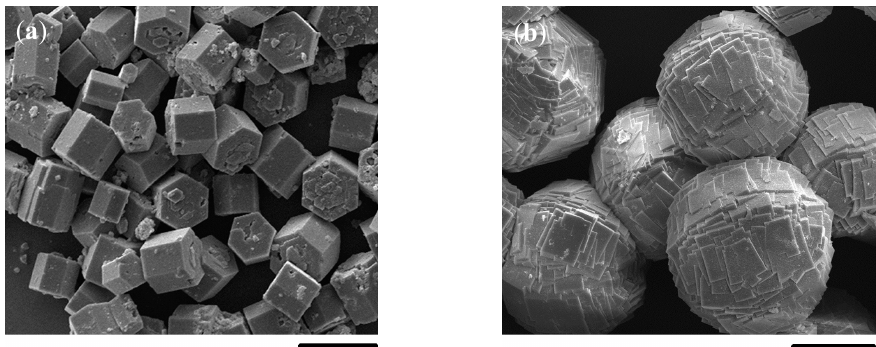
Figure 6. SEM images of SAPO-5 crystal grains using AIP ( a ) and pseudo-boehmite ( b ) as the Al source. Scale bars correspond to 20 μ m.